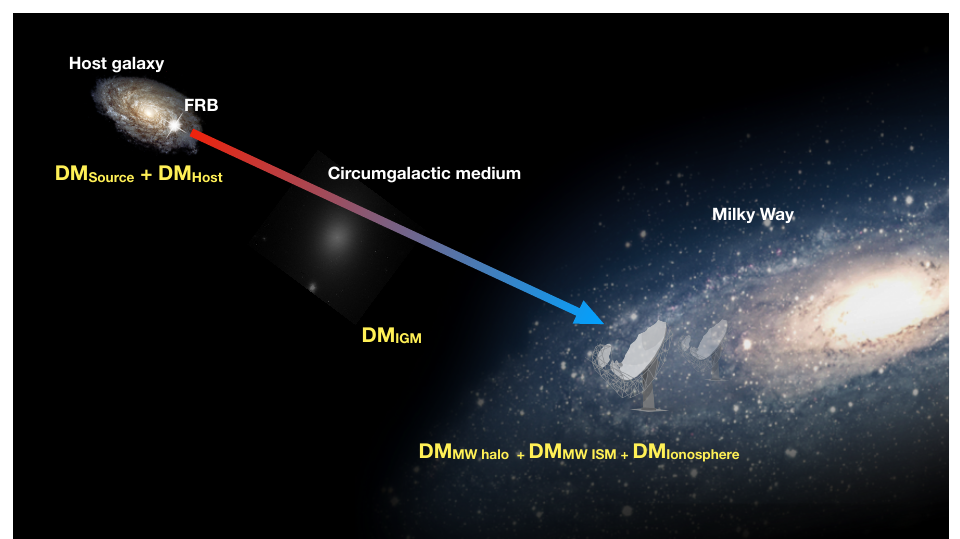
Figure 2. Cartoon of the various DM contributions along the path of propagation of the FRB signal and the corresponding